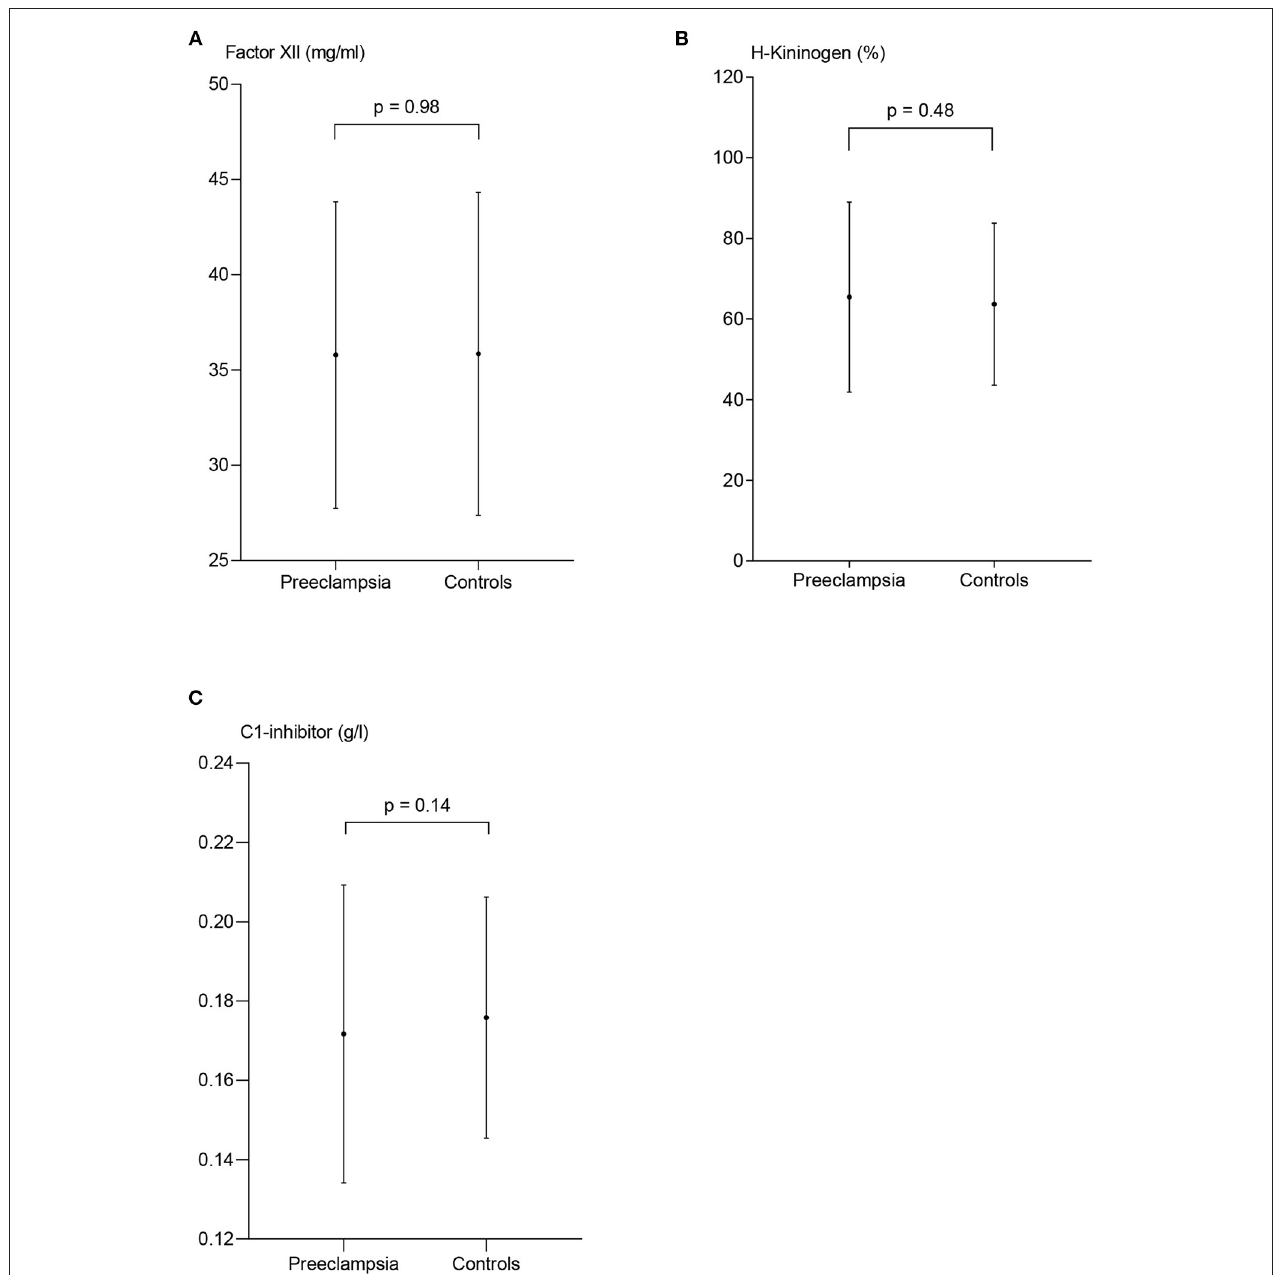
FIGURE 3 | Measures of contact activation in patients with preeclampsia and controls. The plasma concentration of coagulation factor XII (FXII) (A) and H-kininogen (B) are presented as mean ± standard deviation. C1-esterase inhibitor (C) is presented as median and interquartile range, p-values from the paired t-test (A,B) and the Wilcoxon matched-pairs signed rank test (C) between the two patient